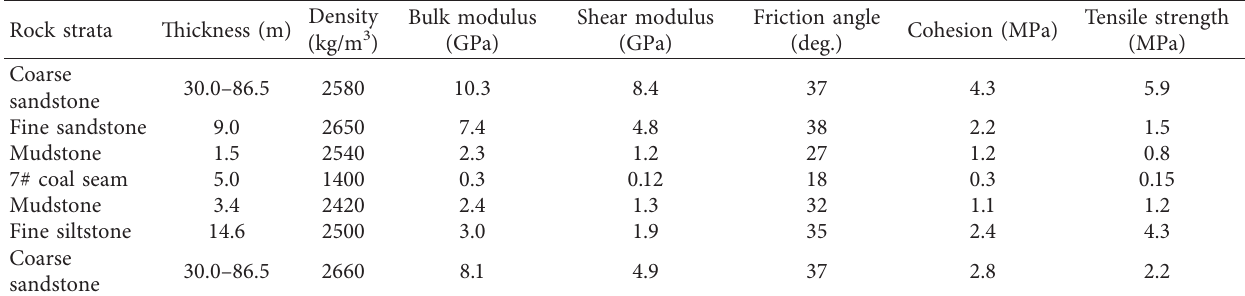
Table 2: Coal-rock layers and mechanical parameters used in the numerical